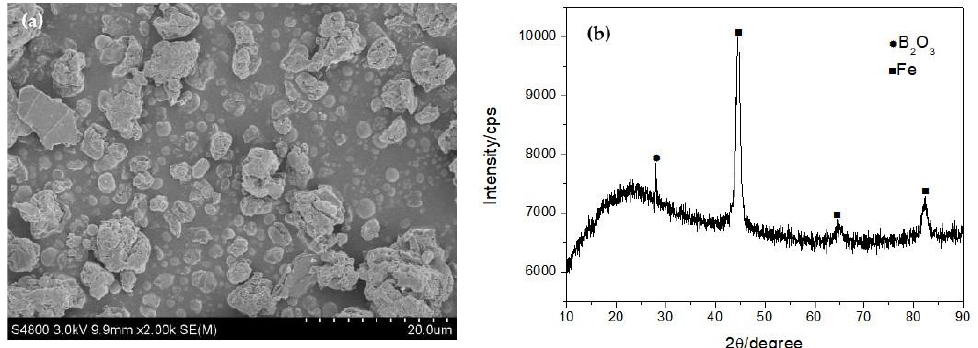
Figure 2. SEM image ( a ) and XRD patterns ( b ) of the product.